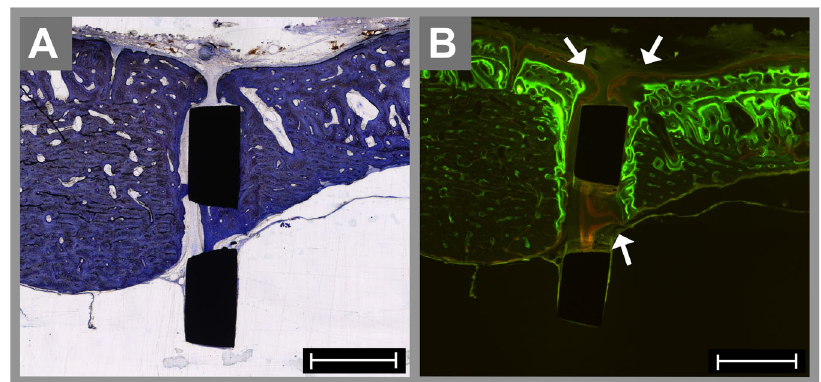
Fig. 5 Histological specimens of an intraosseous titanium implant after 16 weeks stained with toluidine blue ( A ) and visualized by fl uores- cence microscopy ( B ). The osteotomy and the space between the mesh struts are not completely healed by bone tissue. However, the newly